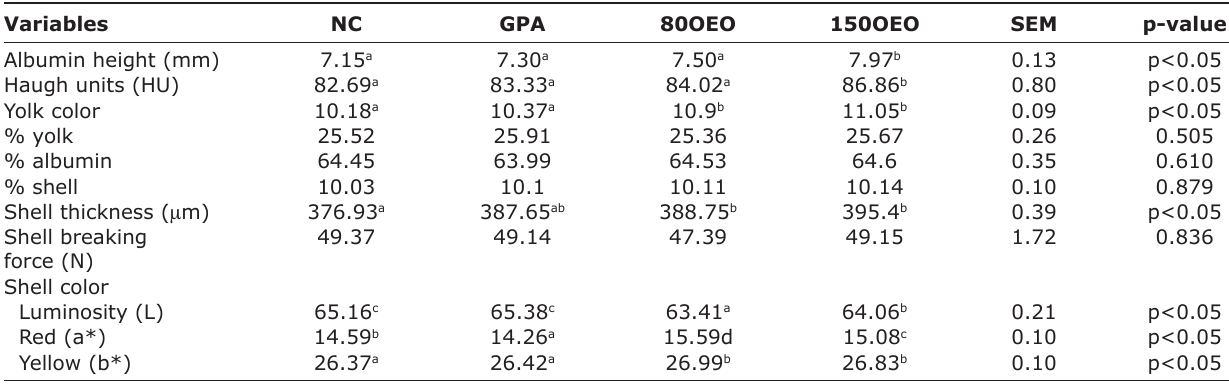
Table-3: Effect of the inclusion of oregano essential oil on the egg quality parameters. Variables